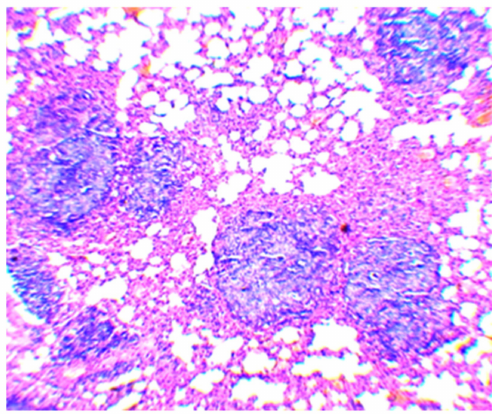
Figure 4. Guinea pig lung immunized with BCG antigens and betulinic acid. A large number of lymphatic follicles with generative centers in the lung tissue is observed. The centers of reproduction are expressed in the follicles (magnification of 50 ×